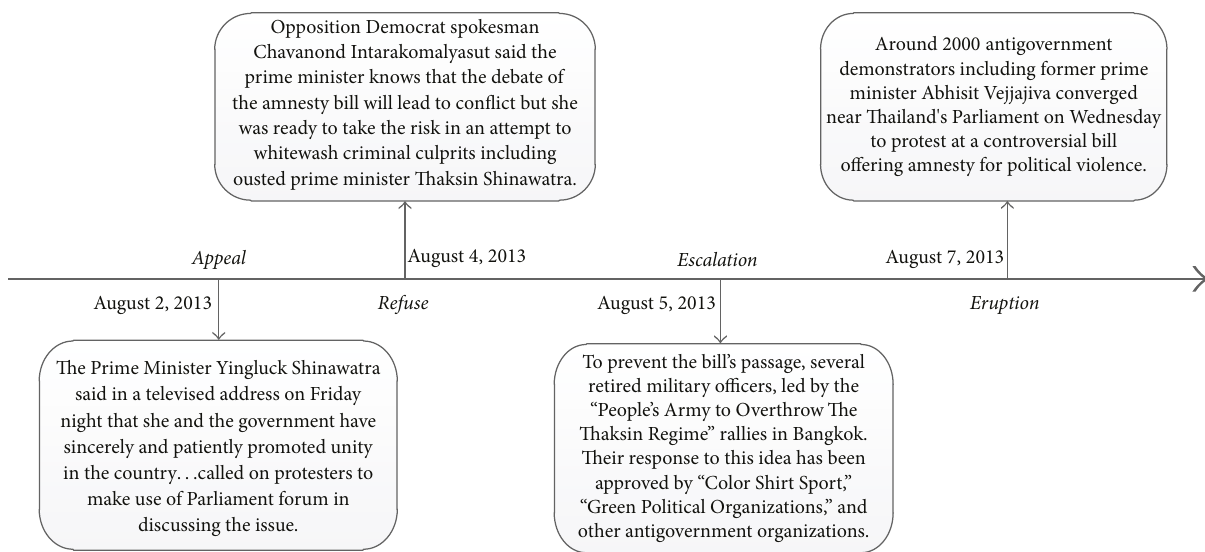
Figure 1: Event development stages before the protest against the amnesty bill at August 7, 2013, in Bangkok, Thailand.